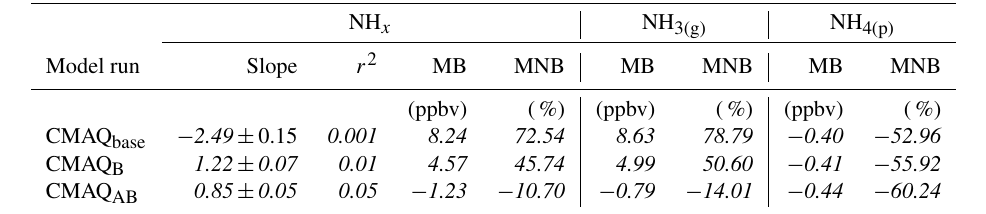
Table 1. Summary statistics of the modeled NH x , NH 3(g) and NH 4(p) concentration comparisons to the ground measurements for all three model runs. Mean bias (MB) = mean (modeled–measured); mean normalized bias (MNB) = mean ([modeled–measured]/measured). Note that low r 2 values, less than 0.10, are highlighted in italics.